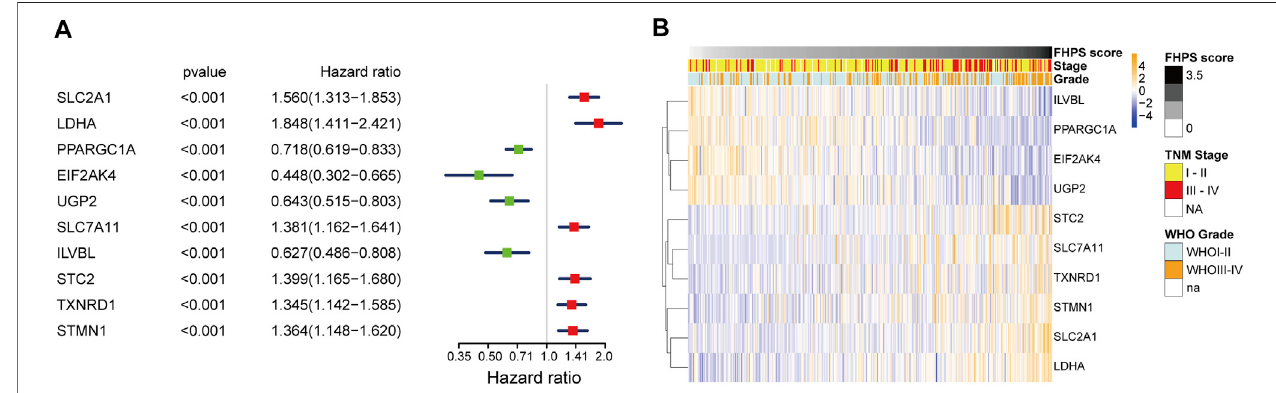
FIGURE 3 | (A) Forest plot of the prognostic ability of the 10 signature genes. (B) Heatmap of the associations between the expression levels of the 10 signature genes and clinicopathological features in the TCGA cohort.